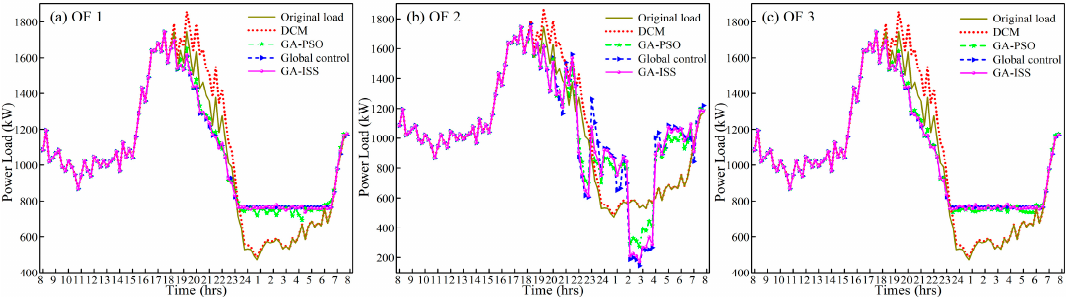
Figure 9. Load profiles for group EV charging of DCM, GA-PSO, Global Control, and GA-ISS under CD-F mode.